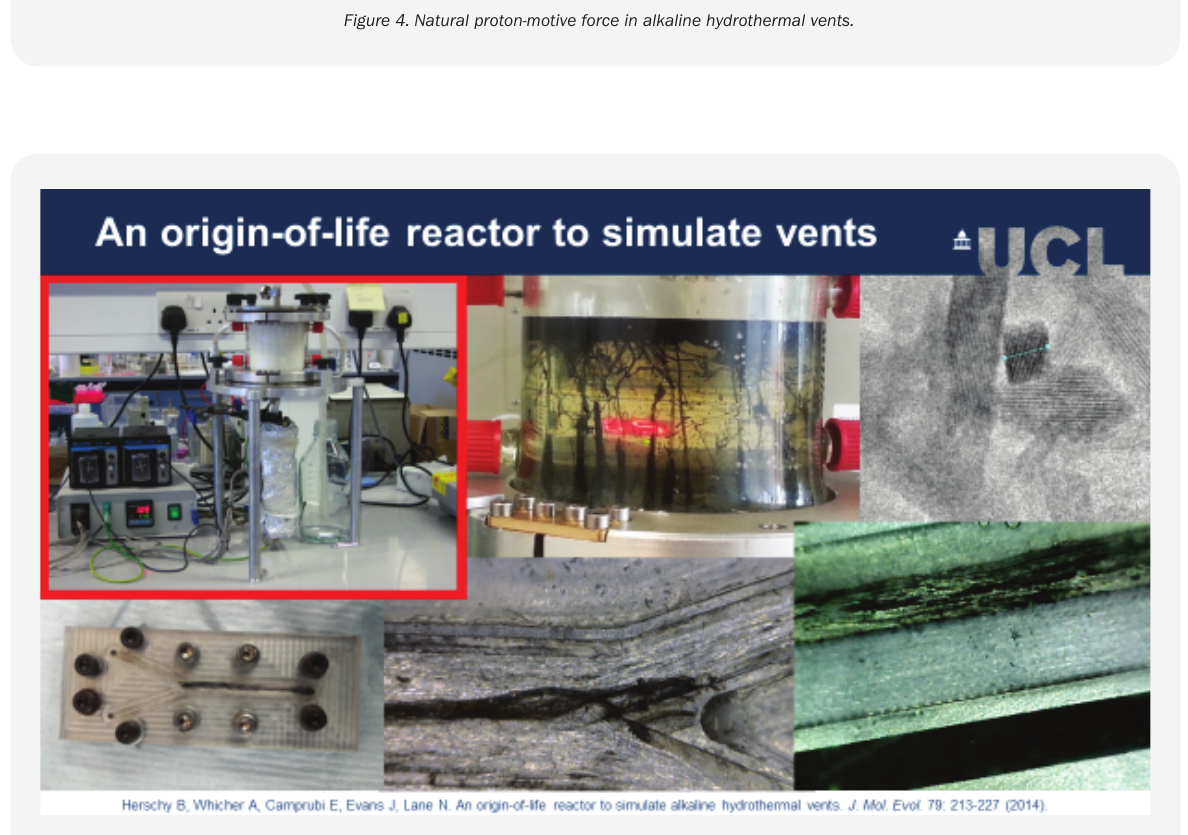
Figure 5. An origin of life reactor to simulate hydrothermal fl